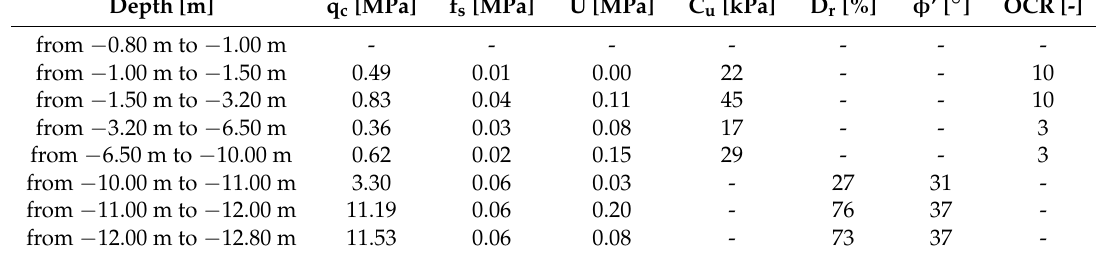
Table 1. Basic Soil Properties of the Scortichino—Bondeno Area. Depth [m] from − 0.80 m to − 1.00 m